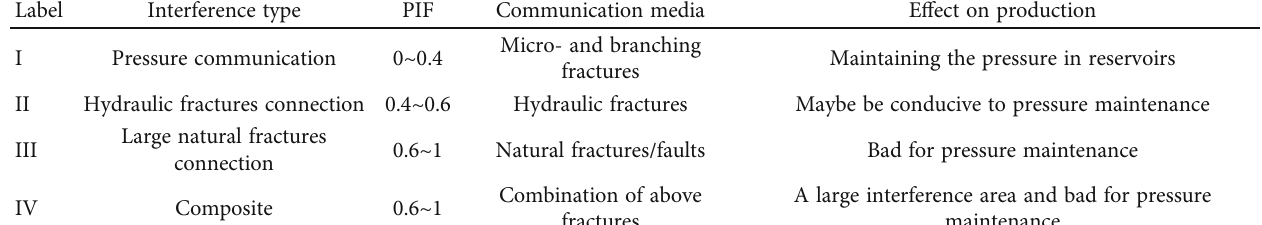
Table 2: The type of interwell fracturing interference.